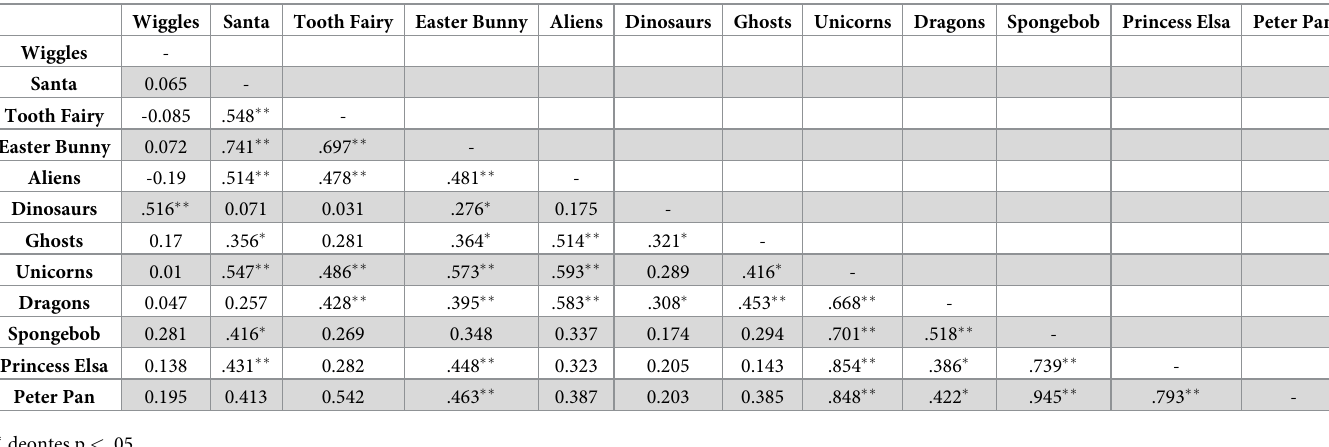
Table 3. Correlation matrix (r values) of ‘realness’ scores for figures.